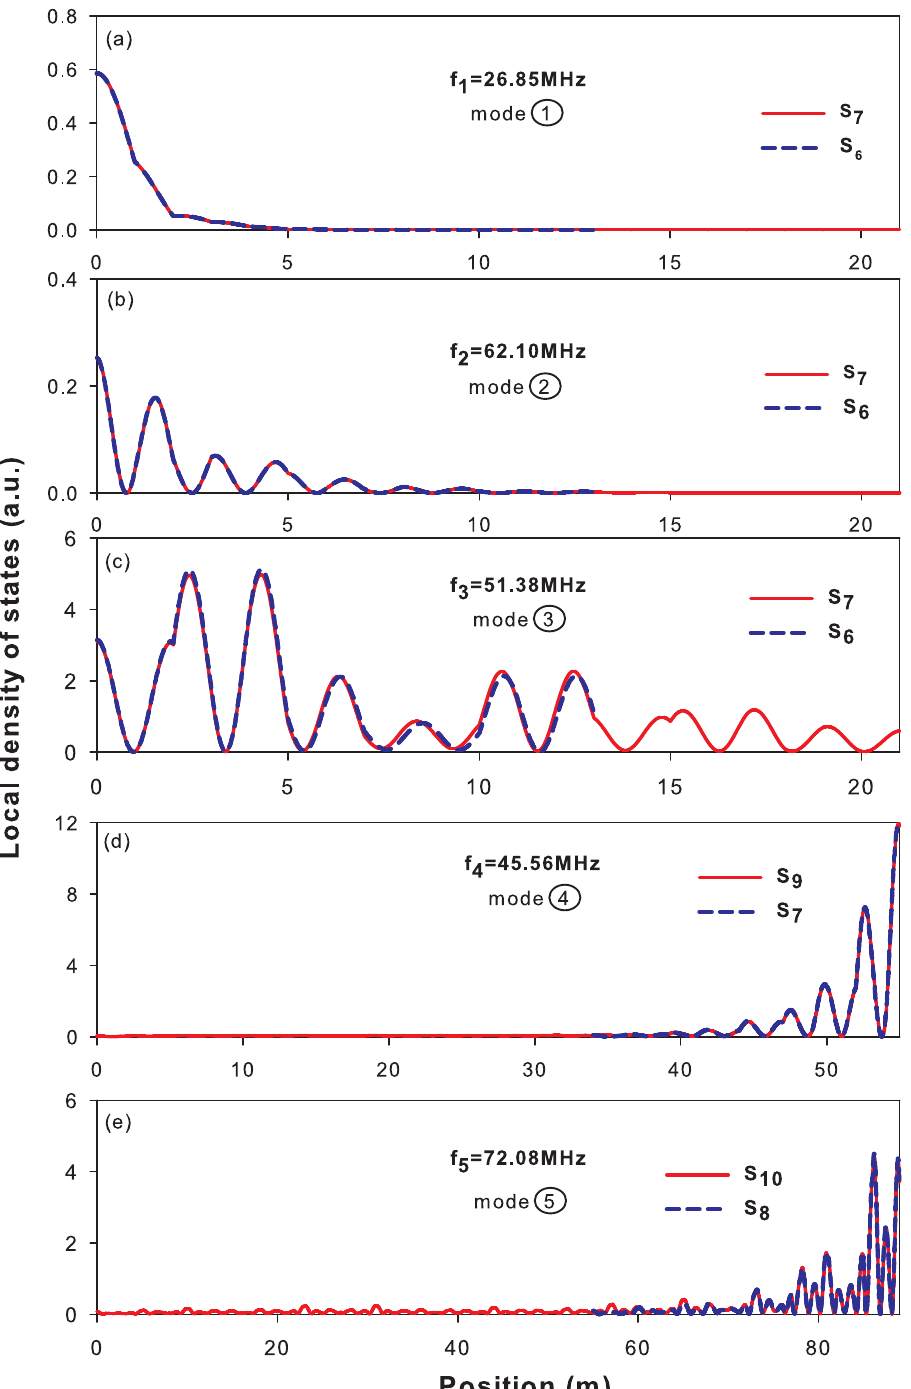
Figure 8. ( a – c ) Spatial representation of the LDOS (in arbitrary units) of the modes labeled 1, 2, 3 in Figure 7 at f 1 = 26.85 MHz ( a ), f 2 = 62.10 MHz ( b ) and f 3 = 51.38 MHz ( c ) respectively. Dashed (solid) lines correspond to the 6th (7th) generation. ( d , e ) Same as ( a – c ) but for the modes labeled 4 and 5 in Figure 7 at f 4 = 45.56 MHz ( d ) and f 5 = 71.93 MHz ( e ), respectively. Dashed (solid) lines correspond to the 7th (9th) and 8th (10th) generation,